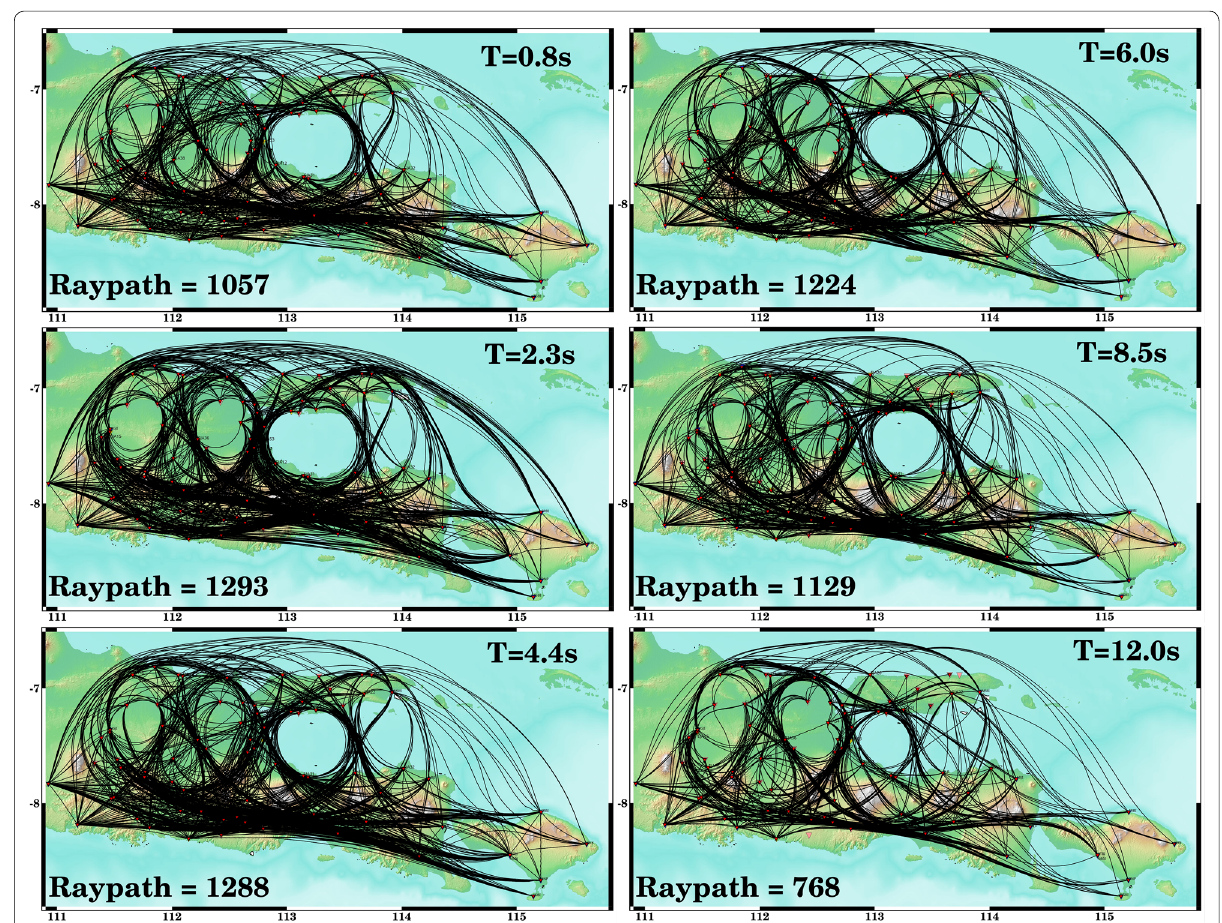
Fig. 5 Ray path distribution at selected periods using damping and smoothing factors of 1800 and 1800, respectively. The histogram shows the distribution of the ray path